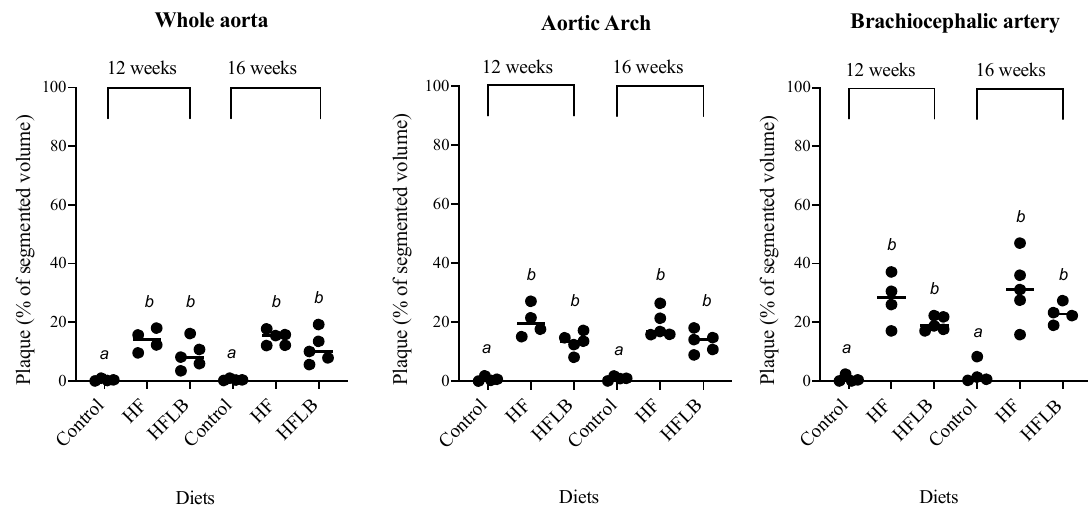
Figure 5. Ex vivo 14T-MRI volumetric assessment of the aortic atherosclerotic plaque in mice fed-hypomethylating (HFLM) and High-Fat (HF) diets, for 12 or 16 weeks. Plaque denotes the volume of plaque relative to the total segmented area. Data not sharing superscript letters differ by p < 0.05. Black circles represent individual values and horizontal lines represent the mean value for each group.